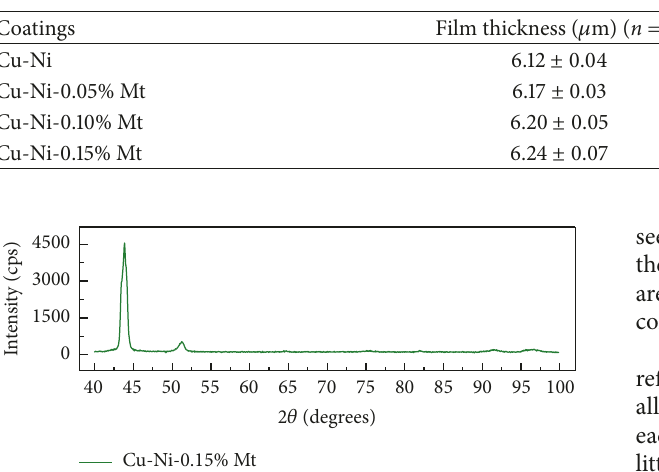
Table 3: Film thickness measured by a profilometer of the pure 90-10 Cu-Ni and Cu-Ni-Mt composite coatings deposited to 30 Coulombs of charge. Crystallite sizes of the pure 90-10 Cu-Ni and Cu-Ni-Mt composite coatings calculated from the Scherrer equation using X-ray diffraction data.